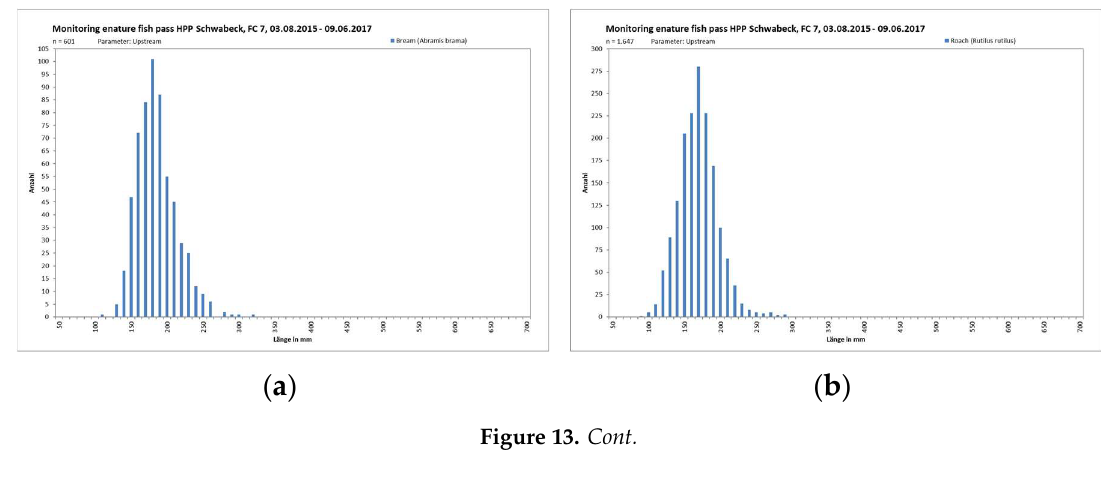
Table 3. Species and individuals detected by FishCam during their migration